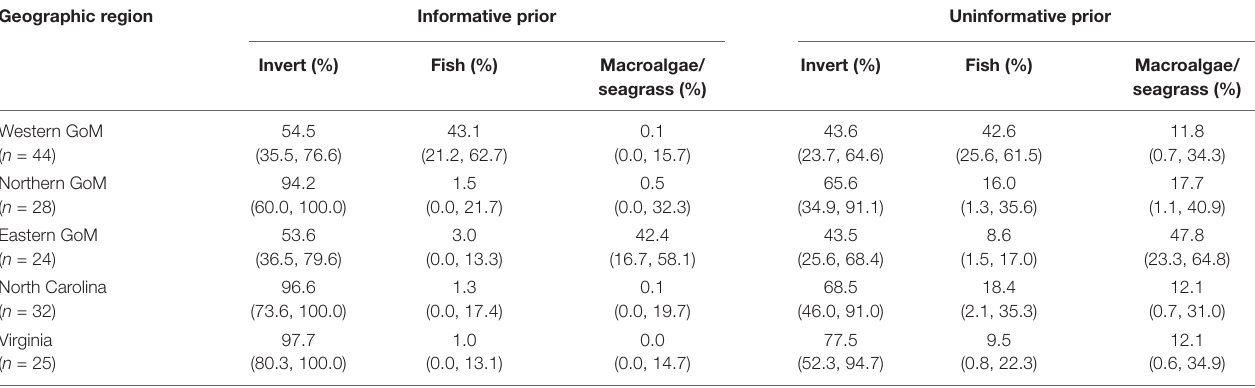
TABLE 4 | Median (95% CI) posterior Bayesian mixing model estimates of diet proportion by geographic region for Kemp’s ridley sea turtles ( n = 153). Geographic region Informative prior Uninformative prior Fish (%)